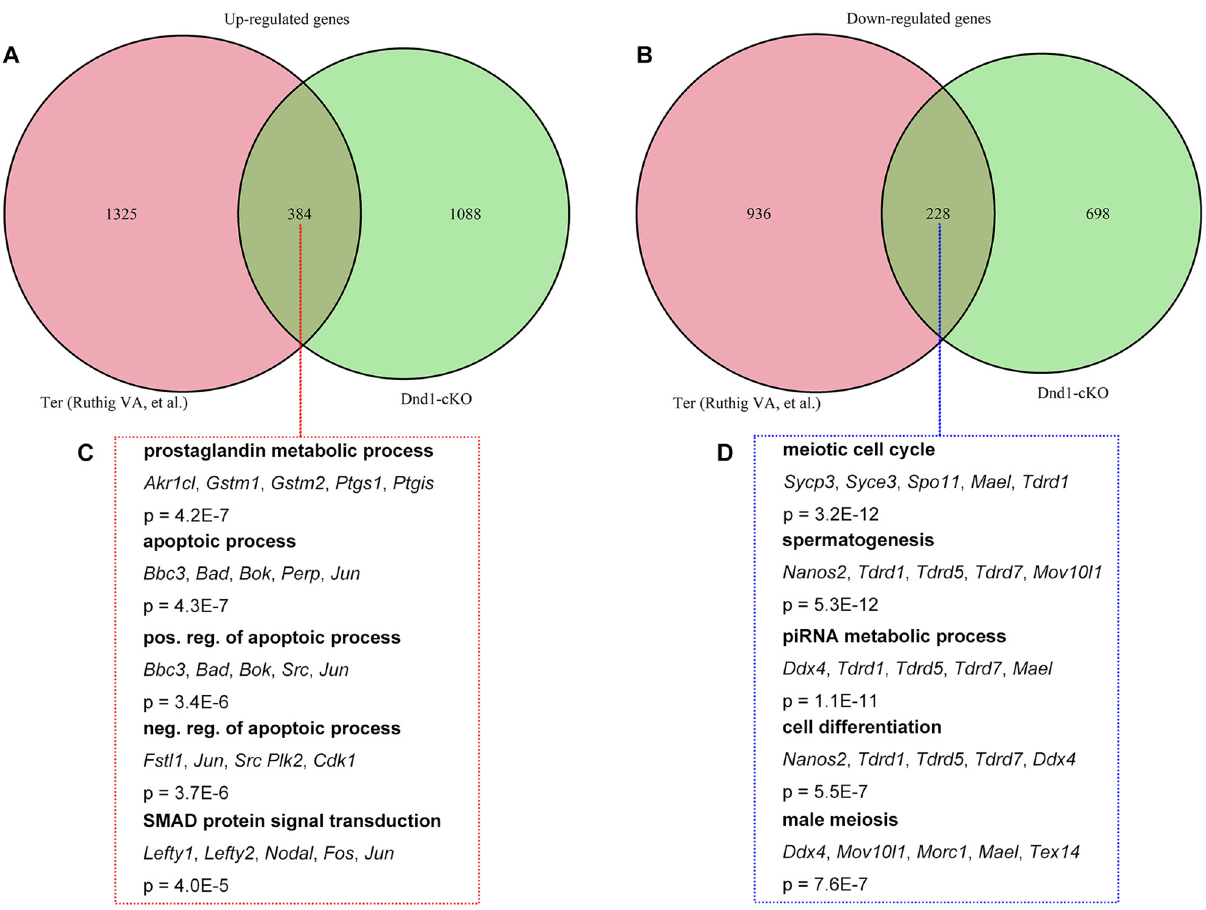
Figure 7. Comparison of transcriptomic changes between Dnd1 -cKO and Dnd1 Ter/Ter PGCs. ( A , B ), The DEGs upregulated ( A ) and downregulated ( B ) in Dnd1 -cKO PGCs at E12.5 and E13.5 are compared with those in Dnd1 Ter/Ter PGCs reported by Ruthig et al., respectively. ( C , D ), GO analysis of commonly upregulated ( C ) and downregulated ( D ) DEGs in both Dnd1 -cKO and Dnd1 Ter/Ter